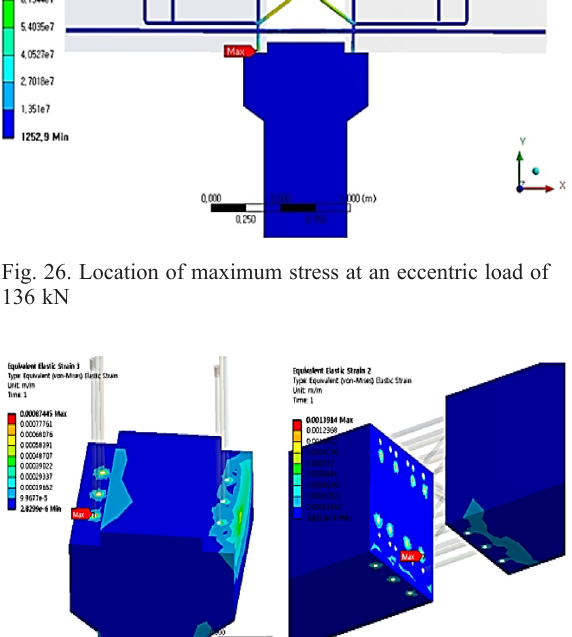
6.3 mm (vertical) and 3.7 mm (horizontal), respectively,